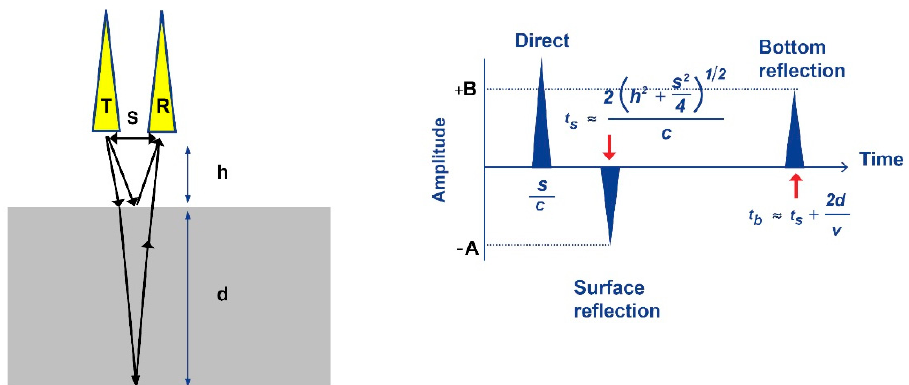
Figure 2. PDP instrument background principle of operation. It is an air-launched GPR that transmits through a transmitter (T) a radio wave pulse, which is reflected from the air/ground interface. The receiver (R) records the transient signal, and the surface reflection event (annotated on the right part of the figure) is identified and automatically processed to estimate the asphalt pavement dielectric permittivity, k r . The GPR wave velocity in the subsurface is annotated with v while the free space propagation velocity, c , is equal to 0.3 m/ns.